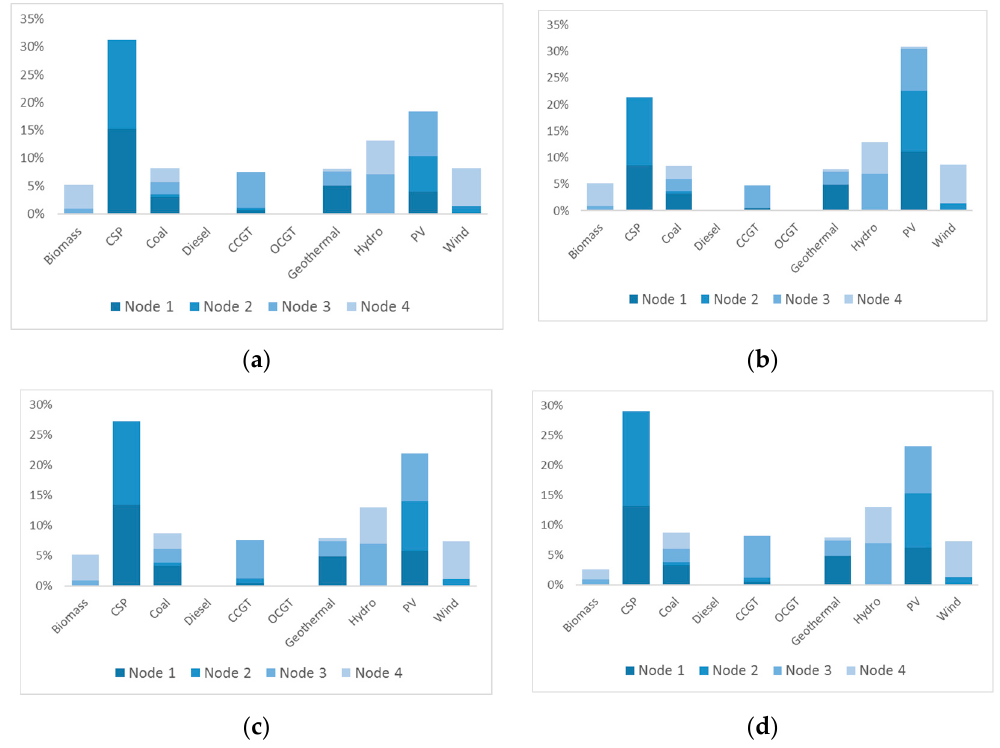
Figure 10. Distribution of energy generation by technology in each node for year 2050, Scenario 0 ( a ), Scenario 1 ( b ), Scenario 4 ( c ) and Scenario 5b ( d ).